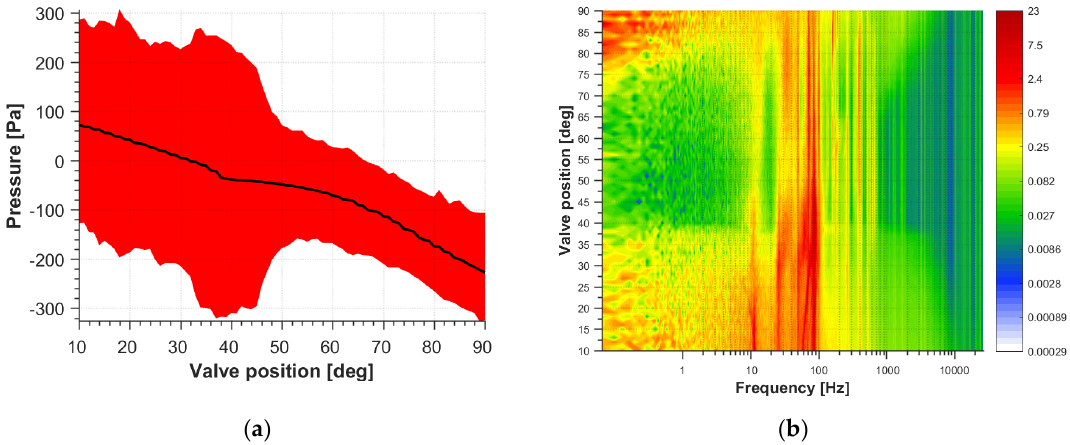
Figure 6. Pressure variation depending on the valve position measured at the inlet at impeller rotational speed 70 Hz. ( a ) The left plot represents the min-to-max plot (red) and the pressure average value (black). ( b ) The right plot represents the spectral map with the colormap in the logarithmic scale.